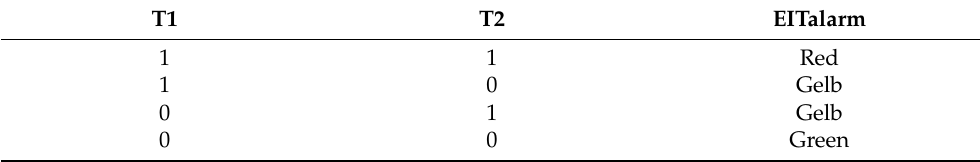
Table 11. Decision matrix of EIT for generating a warning of the possibility of traffic accidents. T1